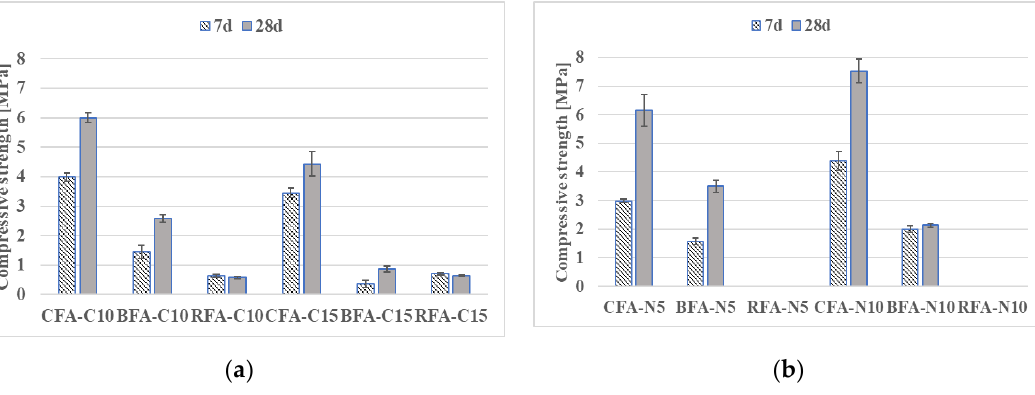
Figure 7. Compressive strength development of mortars with various activators: ( a ) 10% and 15% addition of CaO and ( b ) 5 M and 10 M of NaOH.